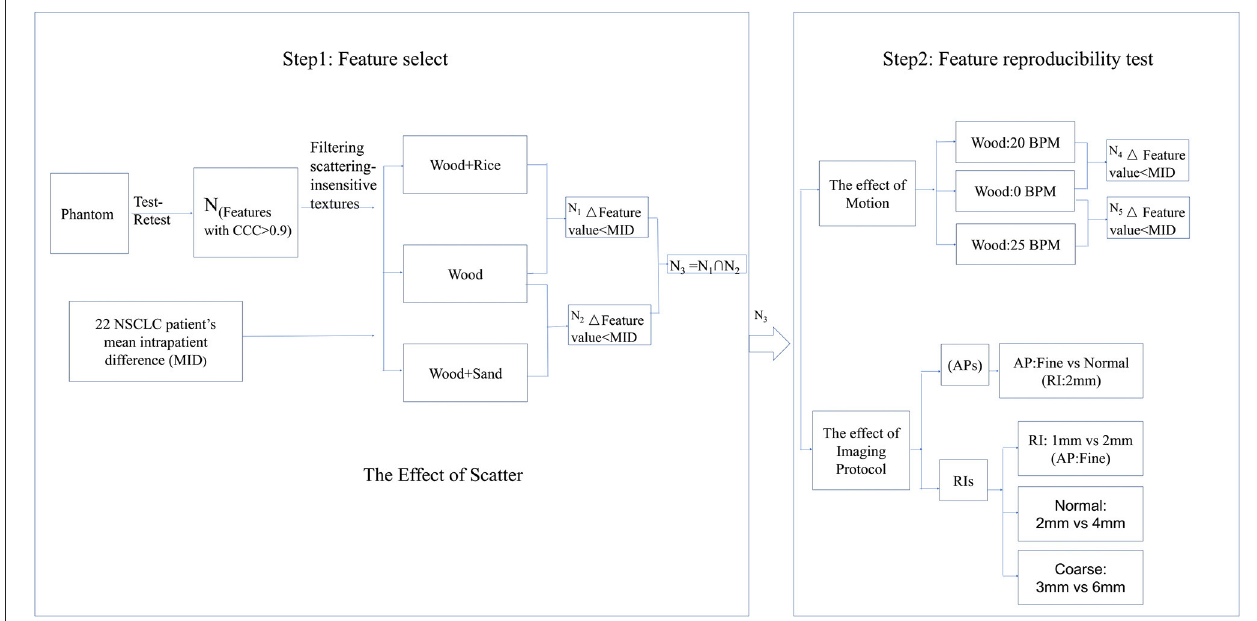
FIGURE 1 | Flow chart of feature selection and the feature reproducibility